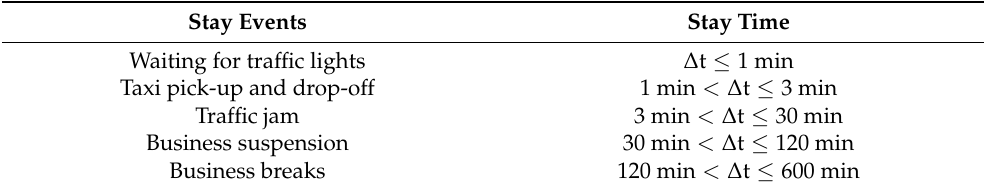
Table 1. Stay events and stay time of